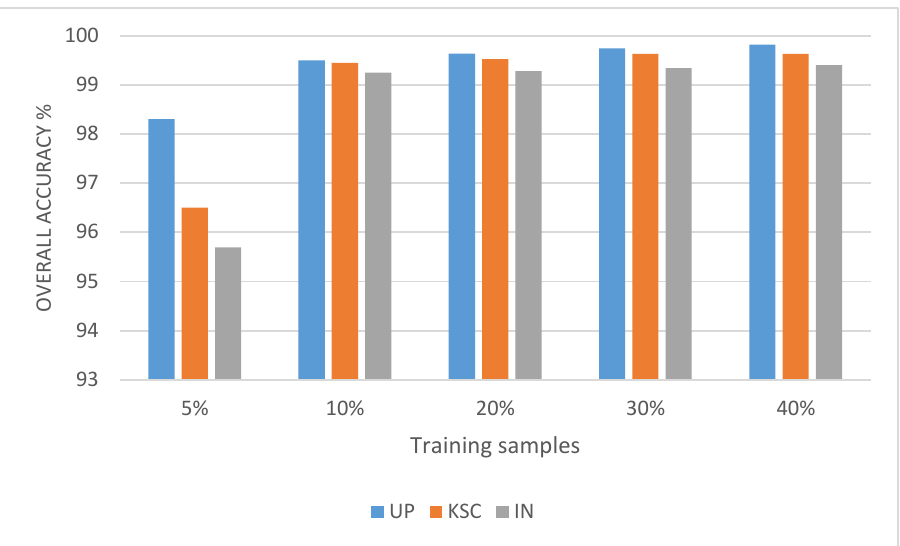
Figure 11. OA (%) of the proposed network with different training samples in IN, UP, and KSC dataset.